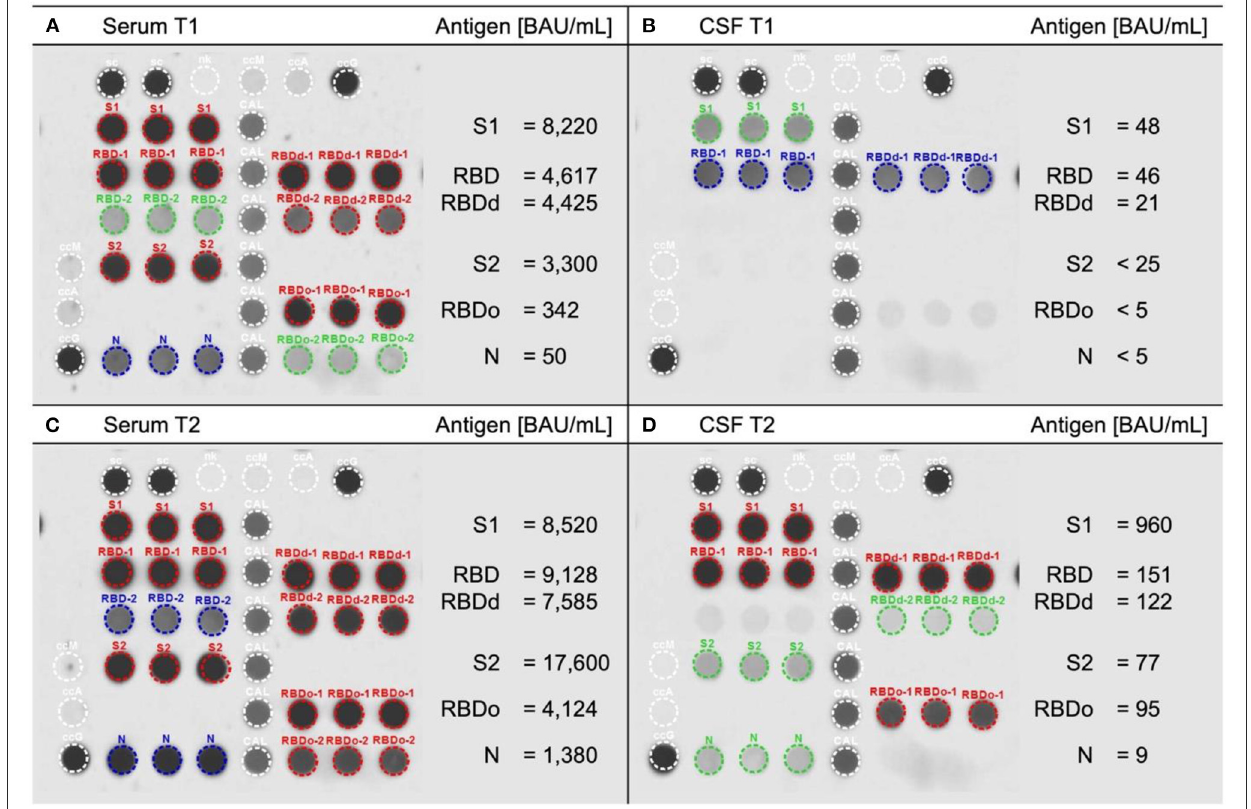
FIGURE3 Measurement of antibodies against SARS-CoV-2 variants. Serum (A, C) and cerebrospinal fluid [CSF, (B, D) ] collected during first vaccine-induced ADEM episode (T1, upper row) and during infection-induced ADEM episode (T2, lower row) analyzed using the SARS-CoV-2 variants of concern ViraChip ® immunoglobin G (IgG) test. This protein microarray detects IgG specific to SARS-CoV-2 surface [spike protein 1 (S1), receptor binding domains of the Wuhan (RBD), delta (RBDd), and omicron (RBDo) variants of concern, and spike protein 2 (S2)] as well as to the nucleocapsid antigen (N). RBDs are provided with high (RBD-1/RBDd-1/RBDo-1) and low (RBD-2/RBDd-2/RBDo-2) antigen concentrations. (A) Serum at T1 shows typical post-vaccine serum pattern with significant S1/RBD/RBDd/S2 but no N reactivity. (C) At T2, massive increase in serum reactivity including to RBDo and N confirms recent omicron variant infection. The synchronous mild increase in CSF reactivity from T1 (B) to T2 (D) proves blood-brain barrier patency of all surface and nucleocapsid IgG. BAU/ml, binding antibody units per milliliter; red/blue/green marking indicates high/moderate/low antigen-IgG